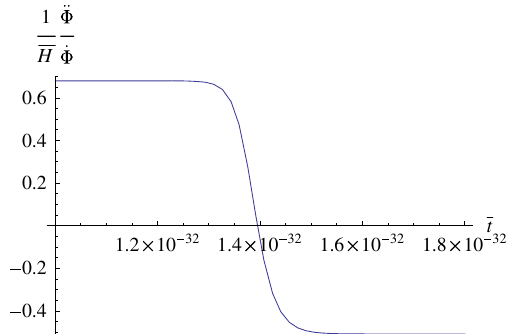
Fig. 4 Thediagrampresentstheevolutionof ¯ ρ m withrespecttothecos- mologicaltime ¯ t .Thetimeisexpressedinsecondsand ¯ ρ m isexpressedin km 2 .Thevalueoftheparameter γ isassumedas3 . 277 × 10 − 6 s 2 Mpc 2 . s 2 Mpc 2 km 2 = 0 . 6911, where H = 67 . 74 km We also assume that Λ . Note that 0 s Mpc 3 H 2 0 the maximum of this function is achieved when ˆ R = 1 2 γ